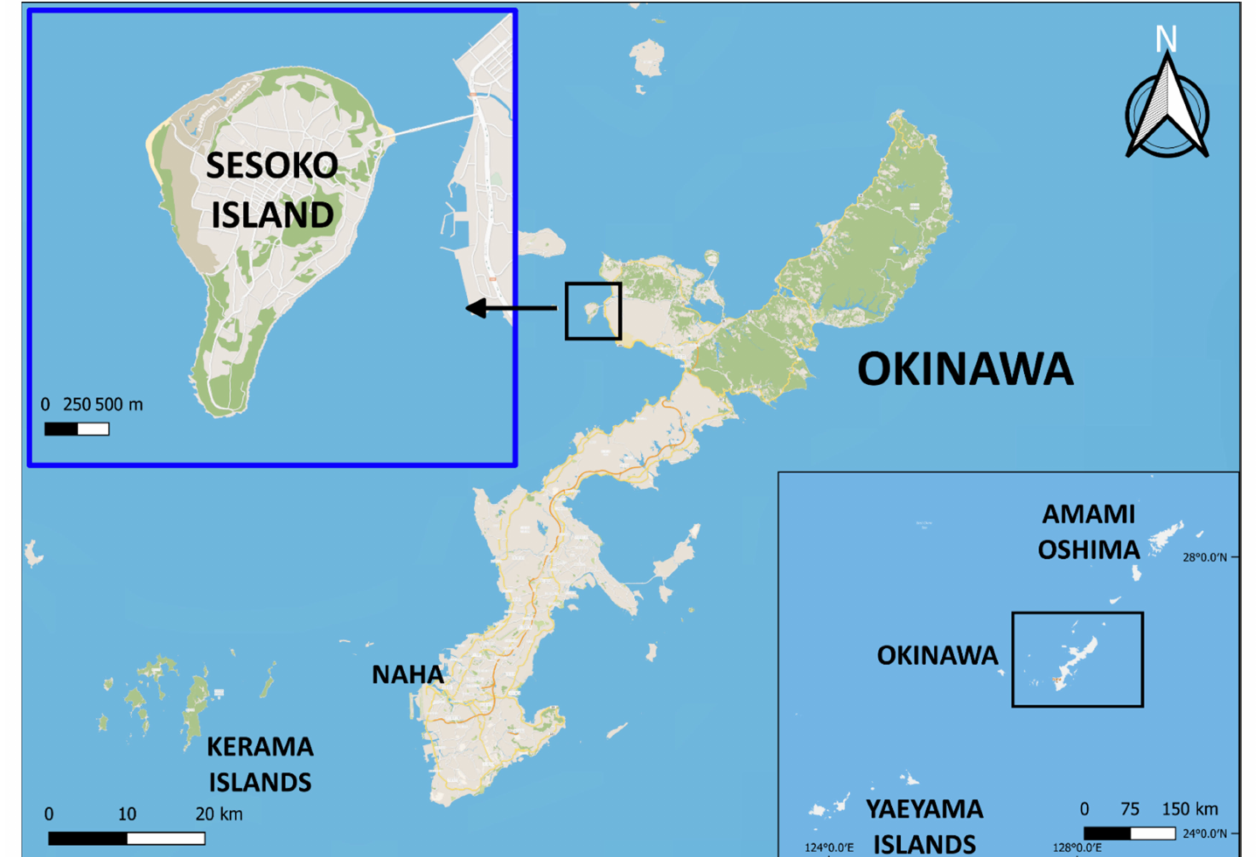
Figure 1. Study area depicting Sesoko Island (Top-Left) located in central western Okinawa Island. Source: HCMGIS plugin, F4 Map-2D (QGis 3.16 long-term